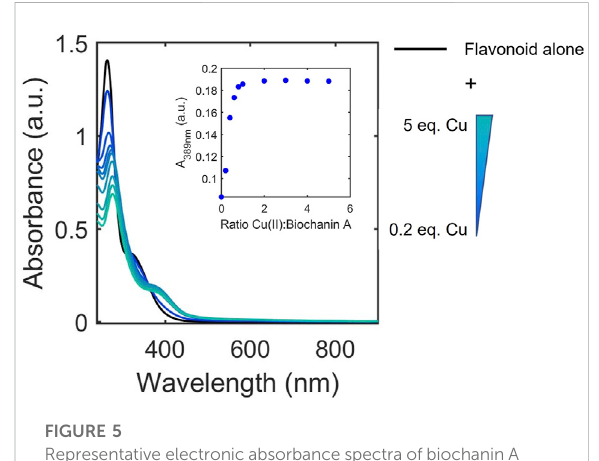
FIGURE 5 Representative electronic absorbance spectra of biochanin A upon addition of 0.2 – 5 equivalences of copper in 50 mM MOPS buffer (pH 7.4) for the determination of binding ratios. The inset shows absorbance at 389 nm where spectral changes occur due to Cu(II)binding tobiochanin A.The changes inabsorbance at 389 nm plateau at 1 equivalence of Cu(II) which indicates a 1:1 binding ratio between biochanin A and